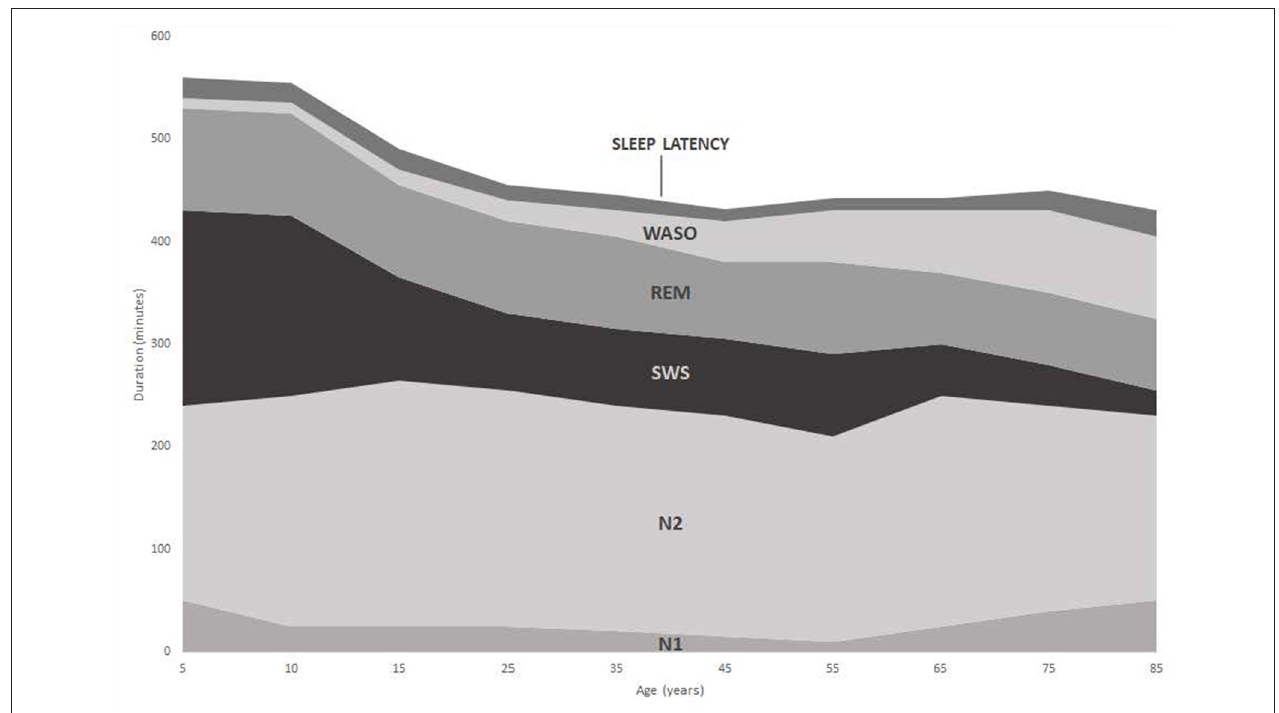
FIGURE 1 | Changes in duration of sleep stages with increasing age [adapted from Ohayon et al. (50)].